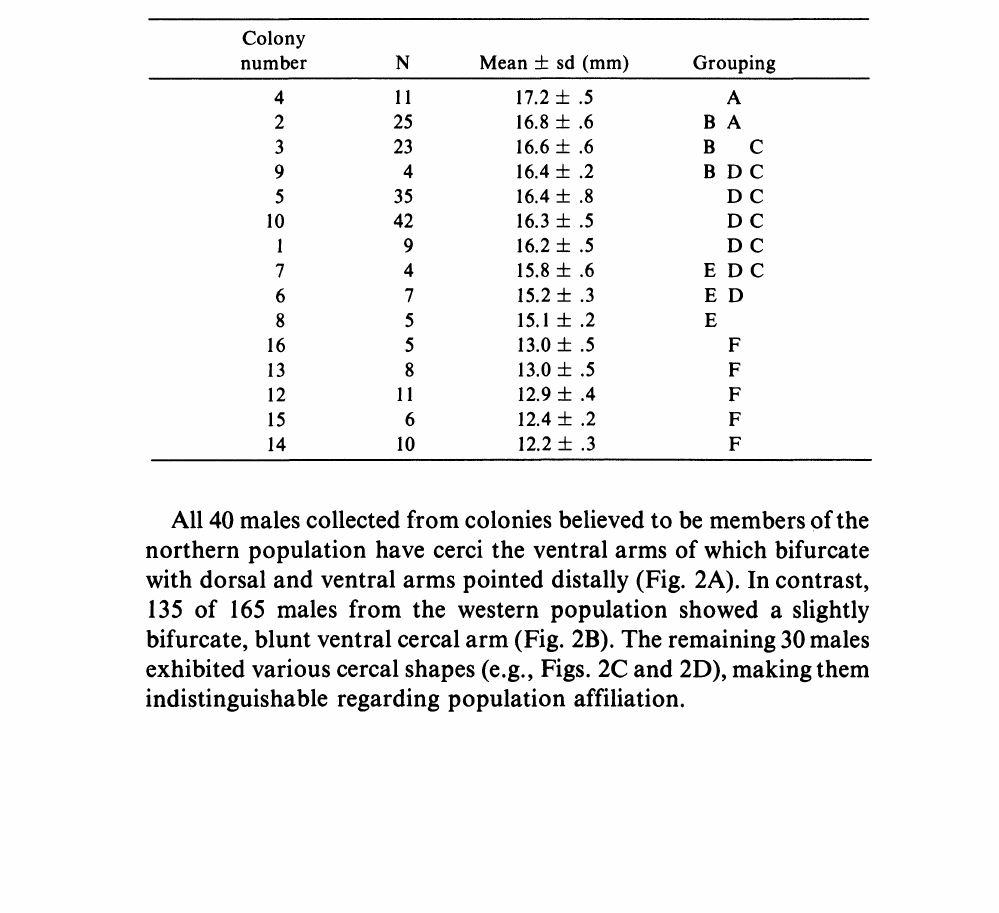
Table 2. Duncan’s multiple range test for variable SPL (subgenital plate length). Means with the same letter and overlapping ranges of means designated by two or more letters are not significantly different. The range of means designated F are significantly different from overlapping range of means designated A, B, C, D and E (p < .05). Colony number N Mean +/- sd (mm) Grouping 4 11 17.2 +/- .5 A 2 25 16.8 + .6 16.6 +/- .6 16.4 +/- .2 16.3 + .5 16.2 + .5 15.8 +/- .6 15.2 + .3 15.1 +/-